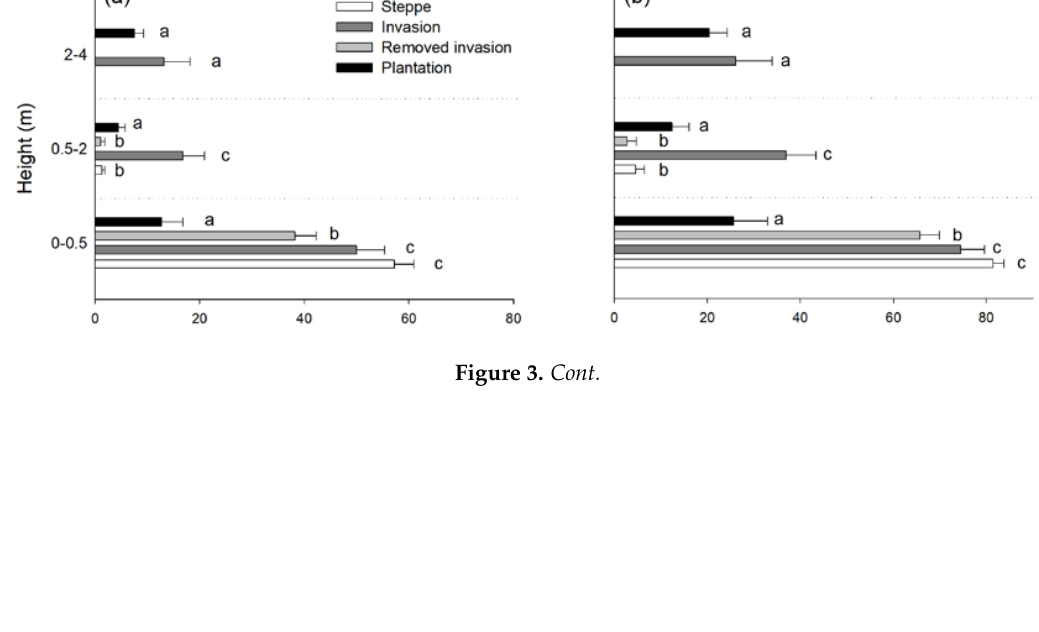
Figure 3. Vertical distribution of the mean fuel intercepts and mean horizontal continuity (±SE) of each treatment grouped into three height classes. Bars represent mean total (live plus dead) fine fuel intercepts. We evaluated the differences in fuel structure among steppe, invasion, removed invasion, and plantation treatments ( a , b ); between pruned and unpruned plantations ( c , d ); among the three levels of invasion ( e , f ); and among the three levels of removed invasion ( g , h ). Different letters indicate significant statistical differences ( p < 0.05) among treatments within each height class based on the generalized linear mixed-effects models.